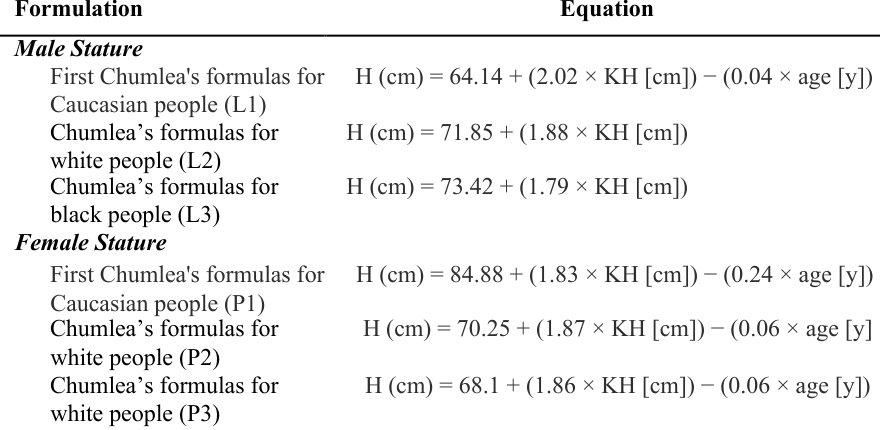
Table 1 Chumlea formulation for estimate the stature